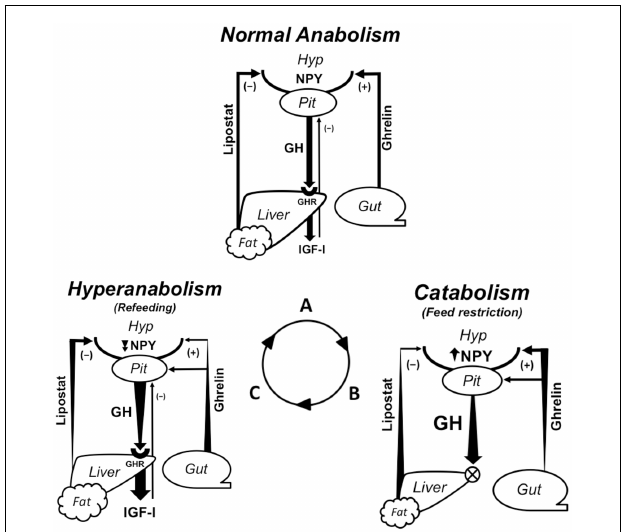
FIGURE 2 | Endocrine regulation of growth and appetite during normal anabolism, catabolism, and hyperanabolism (CG) resulting from feeding status . Growth is regulated by the GH/IGF axis; GH secreted into circulation by the pituitary binds its receptor (GHR) to stimulate hepatic IGF-I production, which systemically drives somatic growth and exerts negative feedback on GH secretion. Lipolysis is an alternate function of GH during catabolism. Peripheral signals from a lipostatic mechanism (anorexigenic), possibly leptin, and ghrelin (orexigenic) regulate energy intake by modulating NPY and other neuropeptides in the central feeding center. Ghrelin also functions as a GH secretagogue. Arrows show the direction of regulatory pathways; widening/narrowing of arrows represents a dynamic increase/decrease in a component over the duration of a particular metabolic state. (A) During regular feeding, energy homeostasis is maintained by matching energy intake and expenditure. Peripheral signals counter-regulate appetite centrally. Growth is regulated by nominal levels of circulating GH, which stimulates IGF-I production via hepatic GHRs. (B) Fasting necessitates catabolic processes to provide energy for basal metabolism. Rising ghrelin production stimulates both appetite and circulating GH levels. Elevated lipolytic GH levels exploit stored energy reserves, decreasing lipostatic signaling. Reduced hepatic GHR expression desensitizes the liver to GH-induced IGF-I production. (C) Refeeding signifies the switch from catabolic to anabolic processes.Temporally elevated orexigens carried over from fasting drive hyperphagia.The return to positive energy status is characterized by the resumption of hepatic GH sensitivity and a steep rise in circulating IGF-I levels, which promotes accelerated growth. Eventually, the repletion of energy reserves and negative feedback from IGF-I returns GH and appetite to nominal levels, marking the return to normal growth rates. (PIT, pituitary;